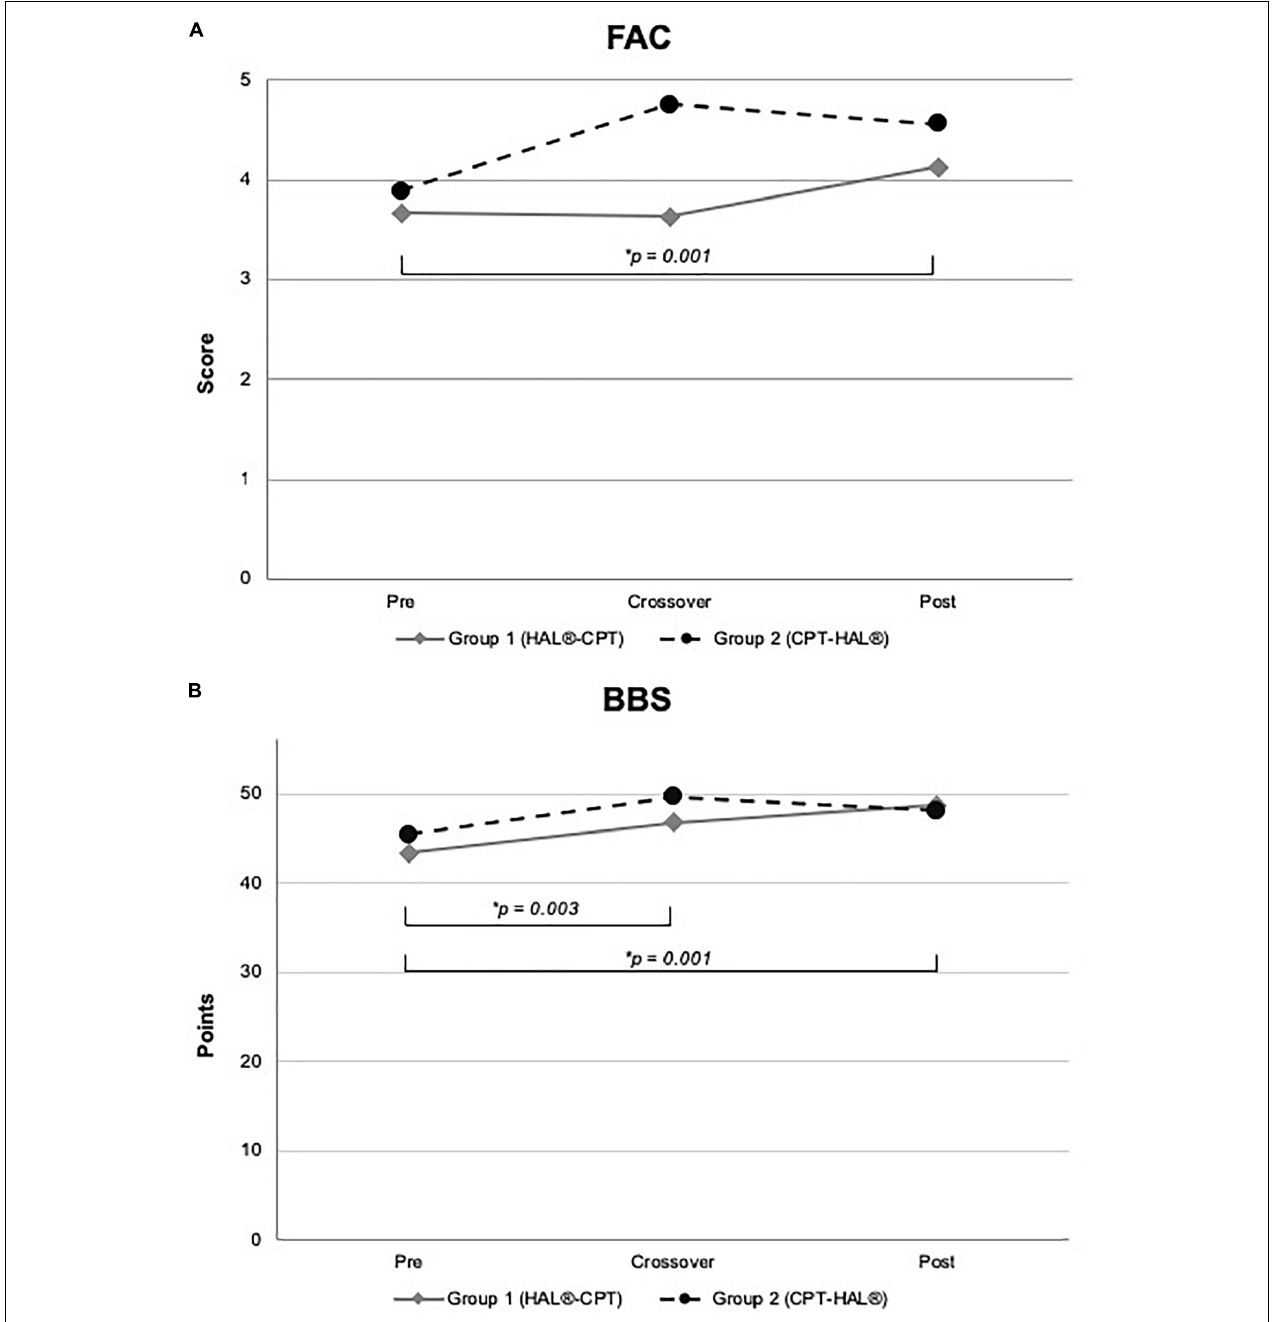
FIGURE 4 | Functional outcome and Berg-Balance Scale. Figure shows mean values for Group 1 (HAL-CPT) and Group 2 (CPT-HAL). FAC = Functional ambulation categories (A) , BBS = Berg-Balance-Scale (B) . ∗ indicated post hoc t -tests after significant effect for factor “time.” p -threshold < 0.017 (Bonferroni